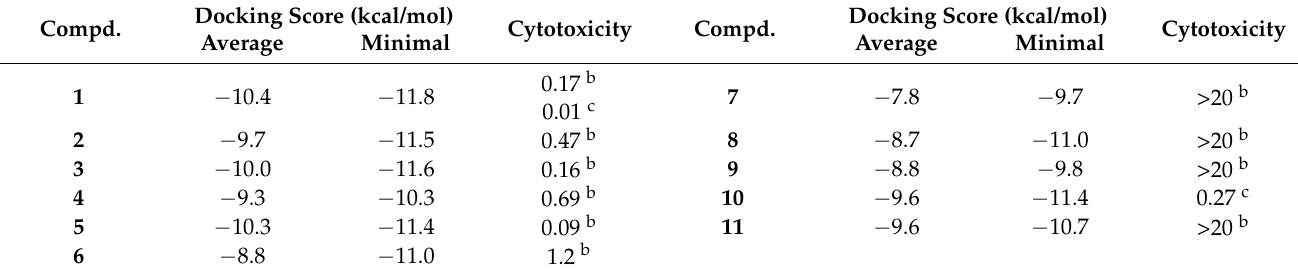
Table 1. Docking scores from the binding to NKA and cytotoxicity of strebloside ( 1 ) and its derivatives ( 2 – 11 ). a.